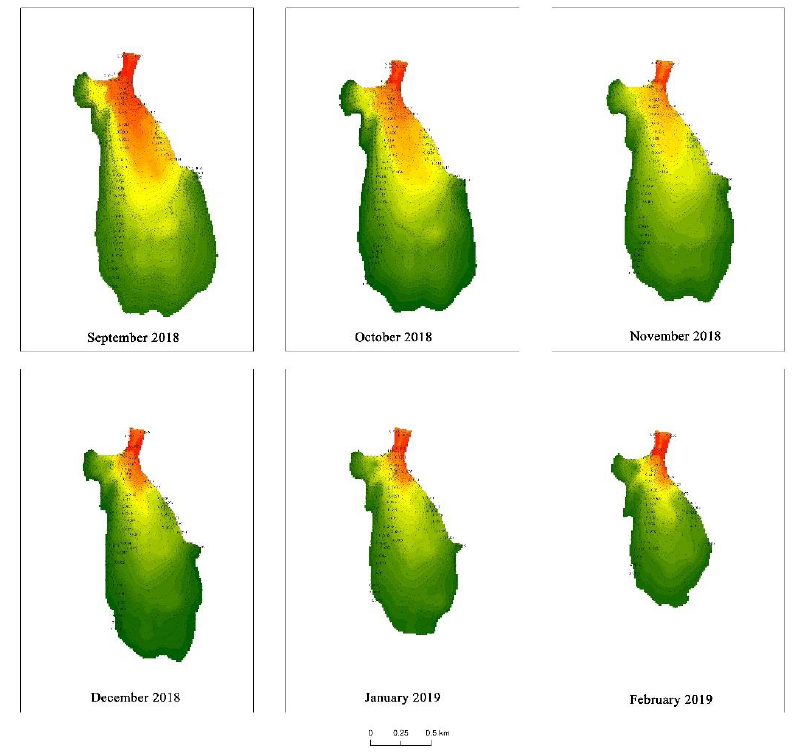
Figure A2. Distribution of flow velocities of the Baigou Canal–Baiyangdian Lake transition zone. Water 2020 , 12 , 674